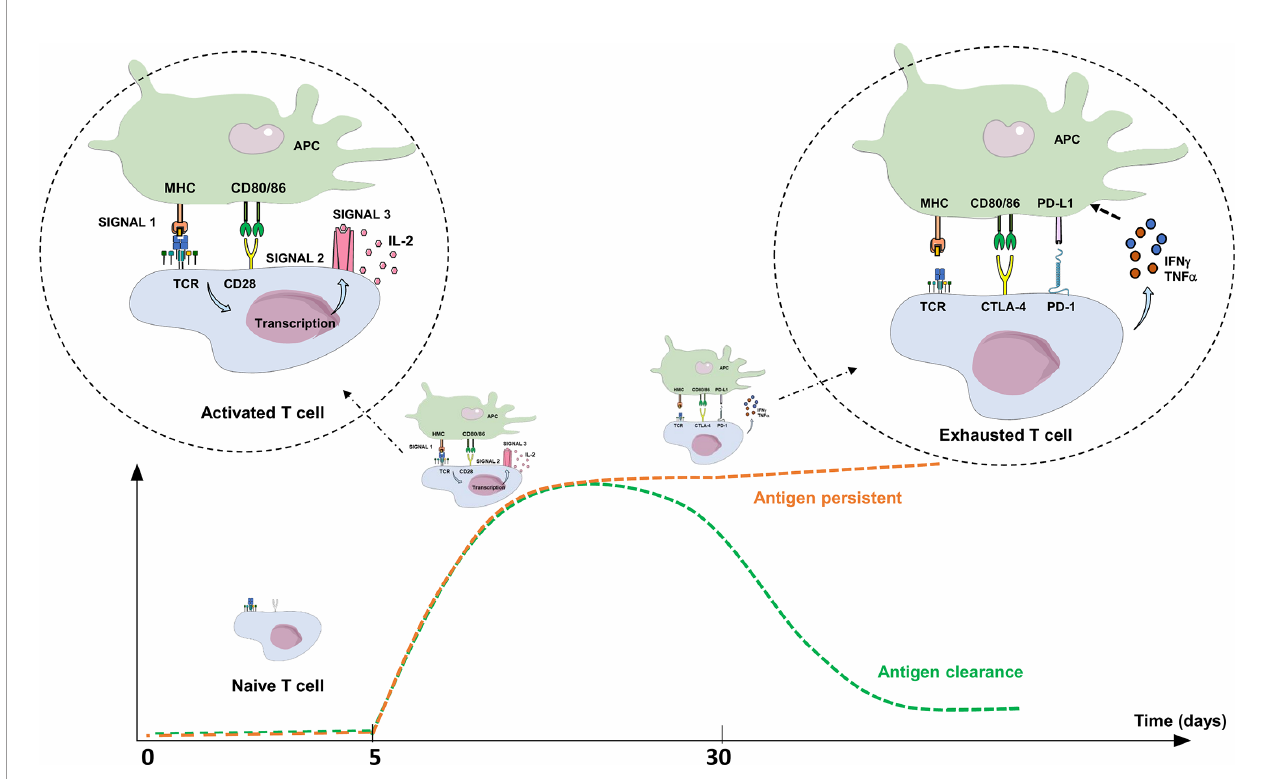
FIGURE 2 | Activation and limitation of the adaptive immune response: physiological concepts. To activate a naive TL during adaptive immune response, APC must present an antigen through MHC to the TCR (signal 1), but also provide an essential co-stimulation signal (signal 2). These co-stimulation molecules, whose expression are induced during innate immune response, are mainly CD80/CD86 (expressed on APC), and CD28 (expressed on T lymphocyte). The activated TL can then proliferate, differentiate into an effector TL, leave the lymph node and move into peripheral tissues to the in fl ammatory site. Without this co-stimulation, the TL becomes anergic. To limit the immune response to a pathogenic antigen, both central and peripheral immune control checkpoints exist. Three to 5 days after activation, TLs physiologically express co-inhibitory receptors (immune checkpoint inhibitors; ICPIs) on their surface, such as CTLA-4 and PD-1. CTLA-4 is expressed by naive TLs residing in the lymph nodes, competes with CD28 and interacts with CD80/86: this regulates the amplitude of TL activation and limits the initial immune response. PD-1 is expressed on effector T lymphocytes and interacts with its ligands (PD-L1/PD-L2). PD-1 expression occurs within 24 h after T-cell activation and decreases with antigen clearance. Unlike CTLA-4, its role is to limit, through various signaling pathways, the immune response in peripheral tissues during the active phase of in fl ammation by decreasing TL activity (exhaustion). TL exhaustion is a progressive process consisting in an effector TL dysfunctional state upon repeated or prolonged stimulation by an antigen, happening in a context of chronic in fl ammation (chronic infection or cancer) with persistent TL stimulation. The expression of PD-L1 is induced by pro-in fl ammatory cytokines such as IFN g or TNF a through a negative feedback loop, thus avoiding collateral damage on tissues. APC, Antigen Presenting Cell; CTLA-4, Cytotoxic T lymphocyte-associated Antigen 4; IFN g : Interferon Gamma; IL-2, Interleukine 2; MHC, Major Histocompatibility Complex; PD-1, Programmed Death 1; PD-L1, Programmed Death Ligand 1; TCR, T-cell Receptor; TNF a , Tumor Necrosis Factor